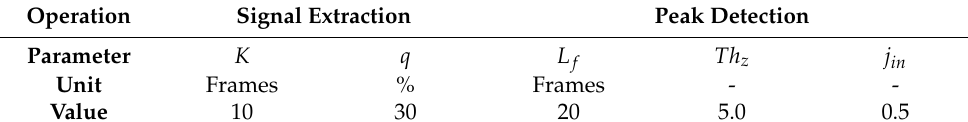
Table 4. The parameters used to visualize spatio-temporal activity in dataset 3.